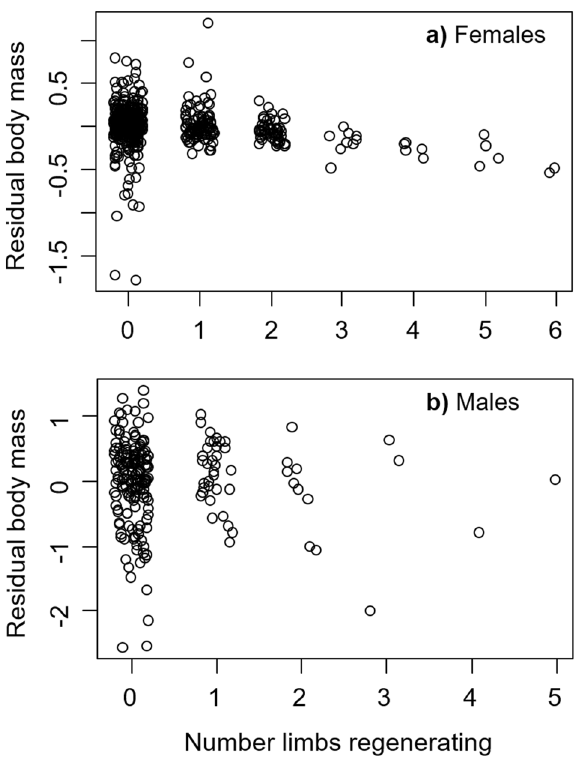
Figure 5. Changes in residual body mass (after accounting for differences with CW) of individual female ( a ) and male ( b ) Hemigrapsus sanguineus sampled in 2019 with the number of missing limbs that are